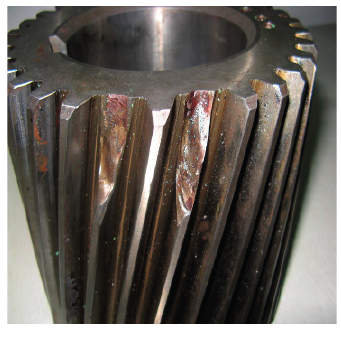
Figure 38. Collision of the gear Z5 on Shaft II of the bevel